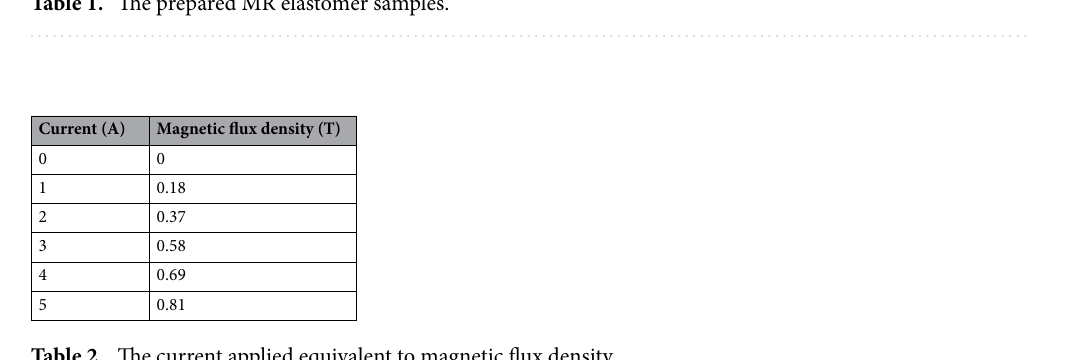
Table 1. The prepared MR elastomer samples.